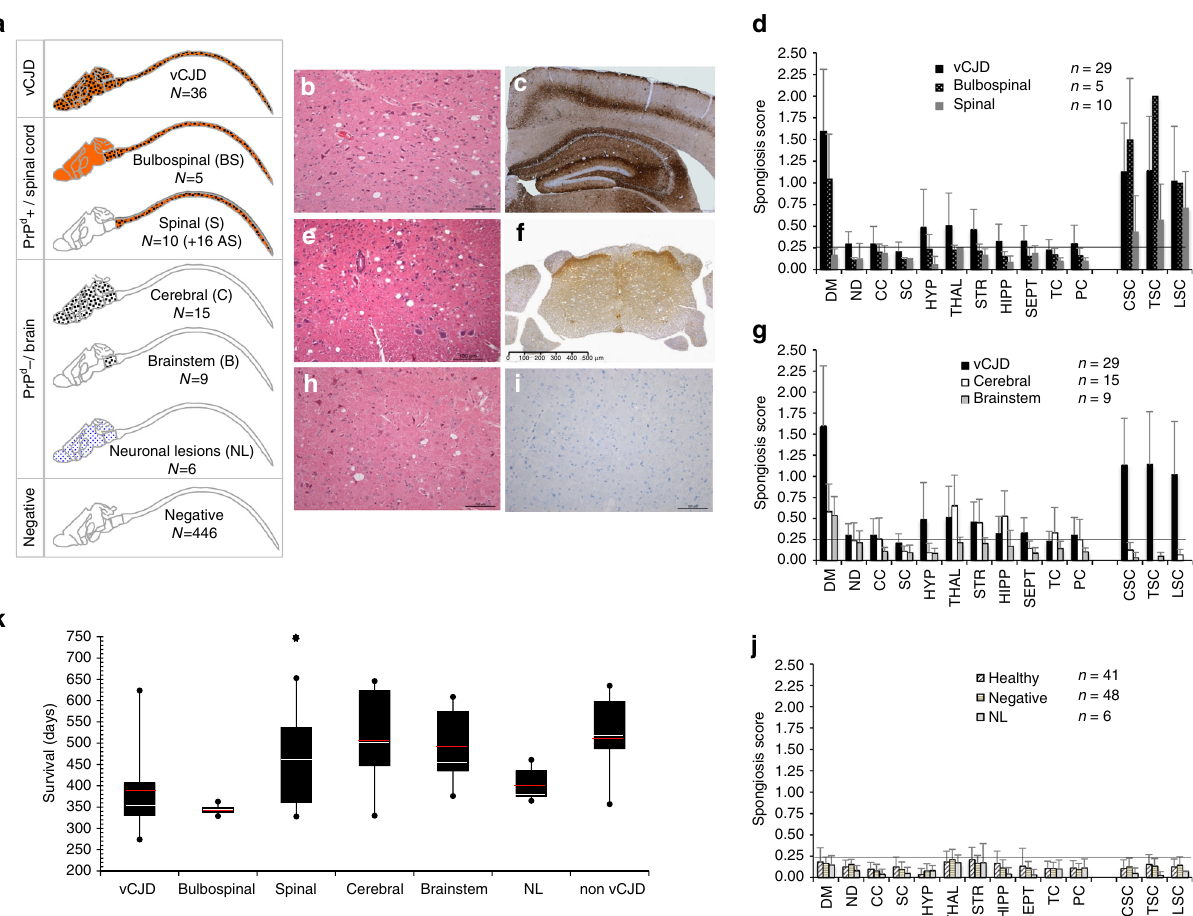
Fig. 2 Distinct disease phenotypes observed in affected mice following intravenous exposure to vCJD-contaminated products. a Synopsis of the distribution of lesions and biochemical features in the central nervous system (CNS) of mice depending on the disease phenotype. Small dots indicate the presence of only neuronal lesions (mainly vacuolation), large dots indicate spongiform change (plus neuronal lesions) and the orange colour indicates the presence of abnormal PrP d . The respective numbers of cases are reported ( N ). vCJD phenotype: b classical spongiform change (hemalun – eosine, H&E stain, 200×) and c abnormal PrP d deposition (Saf-32 anti-PrP antibody, 50×). Bulbospinal phenotype (BS): d spongiform changes were limited to the brainstem and spinal cord without cerebral involvement. Spinal phenotype (S): e spongiform change was limited to part or all of the spinal cord (H&E stain, 200×) but d no obvious brain lesion. f Accumulation of PrP d in the spinal cord and dorsal roots was detected by immunohistochemistry in those 10 animals and the 16 aging spinal (AS) mice. Cerebral phenotype (C): moderate neuronal lesions and h cerebral spongiform change (H&E stain, 200×) with g a topographical distribution similar to vCJD mice (among them, 9 animals exhibited spongiform change limited to the brainstem, and were sub-grouped under the brainstem phenotype, or B). i They exhibited no accumulation of peripheral or central PrP d (Saf-32 anti-PrP antibody, 200×) that was detectable using conventional techniques (ELISA, western blot and/or immunohistochemistry). Neuronal lesions only phenotype (NL): six animals showed apoptotic neurons with vacuolation in the brain ( j ) without spongiform change or detectable accumulation of PrP d . Mean (+standard deviation) spongiosis pro fi les ( d , g , j ) observed for the different disease pro fi les. The horizontal line corresponds to the limit of signi fi cance. DM dorsal medulla, ND nucleus dentatus, CC cerebellar cortex, SC superior colliculus, HYP hypothalamus, THAL thalamus, STR striatum, HIPP hippocampus, SEPT septum, TC temporal cortex, PC parietal cortex, CSC cervical spinal cord, TSC thoracic spinal cord, LSC lumbar spinal cord. k Survival time distribution of neurologically affected mice according to their disease phenotypes. Red and white lines indicate the means and medians, respectively (the black star over spinal phenotype correspond to the 16 AS resistant PrP d (PrP res ) was detected in their brains using classical biochemical diagnostic methods (ELISA and western blot), as a con fi rmation of their positive prion infection status, as expected. None of the negative control animals exhibited neurological signs. After intravenous exposure to exogenous preparations (soluble infected brain extracts) or endogenous preparations (infected macaques) developed fatal neurological impairments with incidences ranging from 10 to 100% depending upon the